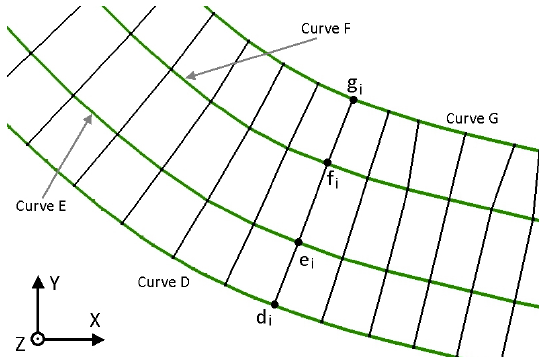
Figure 22. Curves D, E, F, and G and the endpoints for the cross-section construction.